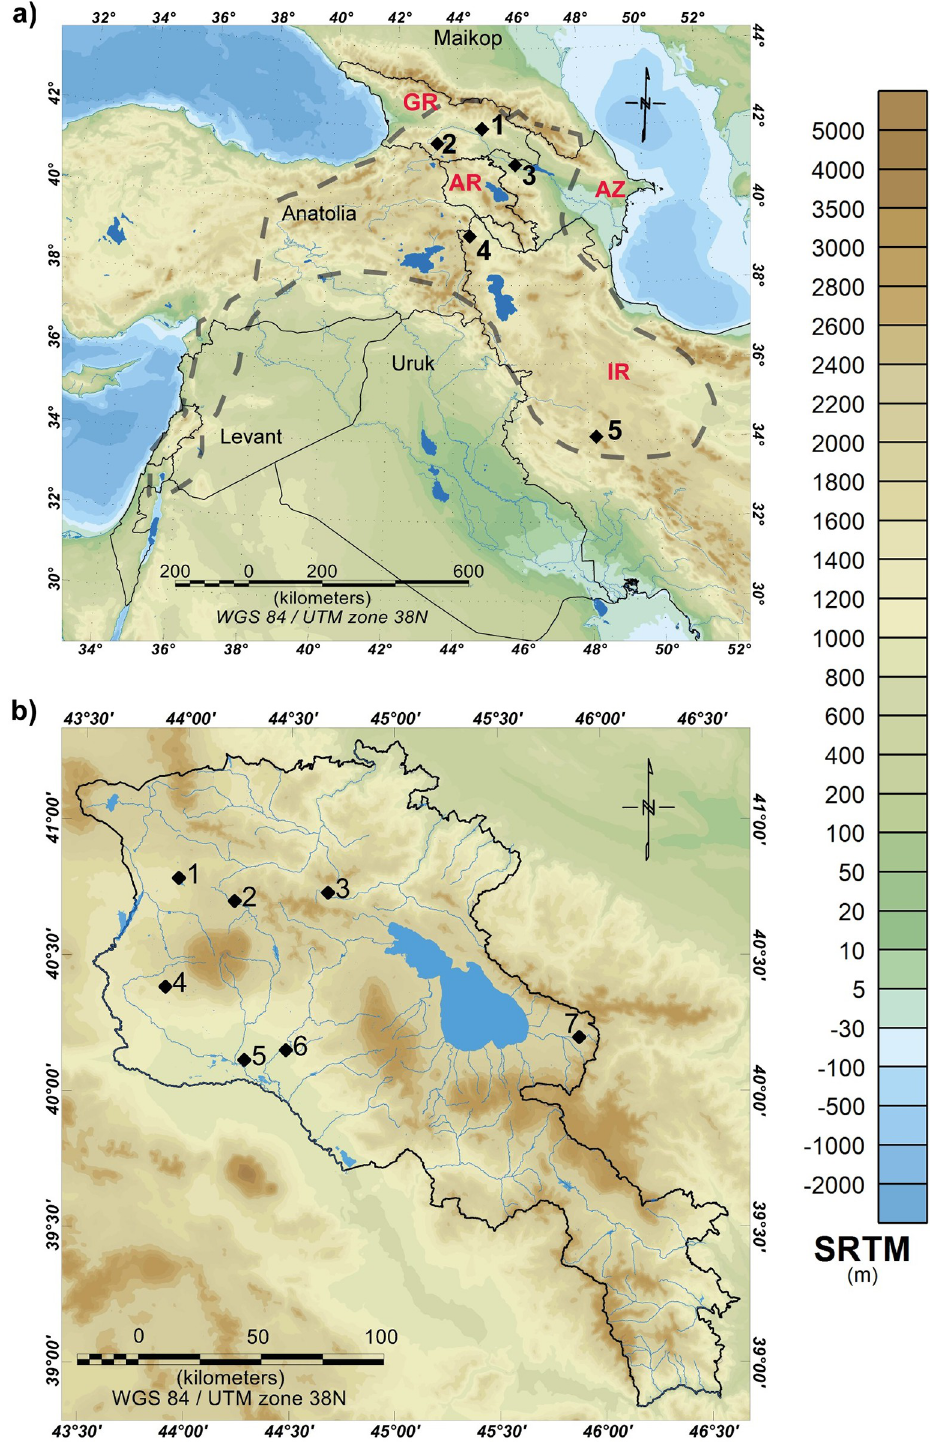
Fig 1. Topographic map of the Greater Caucasus (including Armenia) and the Ancient Near East. (a) Map of the Greater Caucasus and Ancient Near East displaying the extent of the Kura-Araxes cultural phenomenon in dashed lines, approximated [19] (AR is Armenia, GR is Georgia, AZ is Azerbaijan, and IR is Iran), representing sites mentioned in text (1) Natsargora and (2) Chobareti in Georgia, (3) Mentesh Tepe in Azerbaijan, (4) Ko¨hneh Shahar and (5) Godin Tepe in Iran. (b) Map of Armenia, including rivers and one of the major freshwater lakes in the